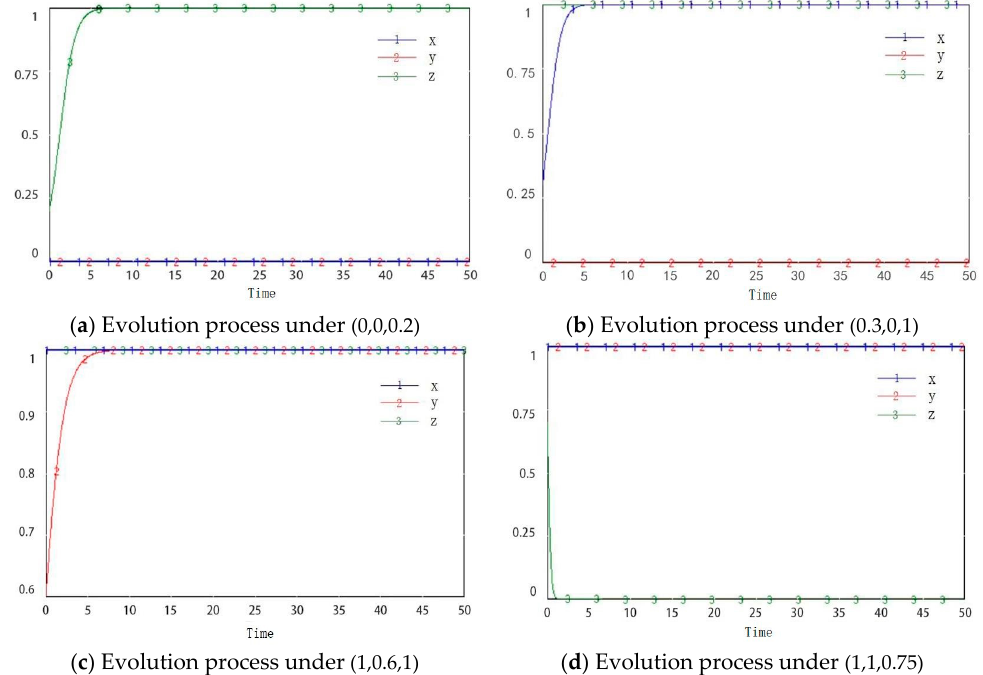
Figure 5. Evolutionary game process of one population’s mutation when initial state is pure strategies. (2) Equilibrium stability analysis of mixed strategy